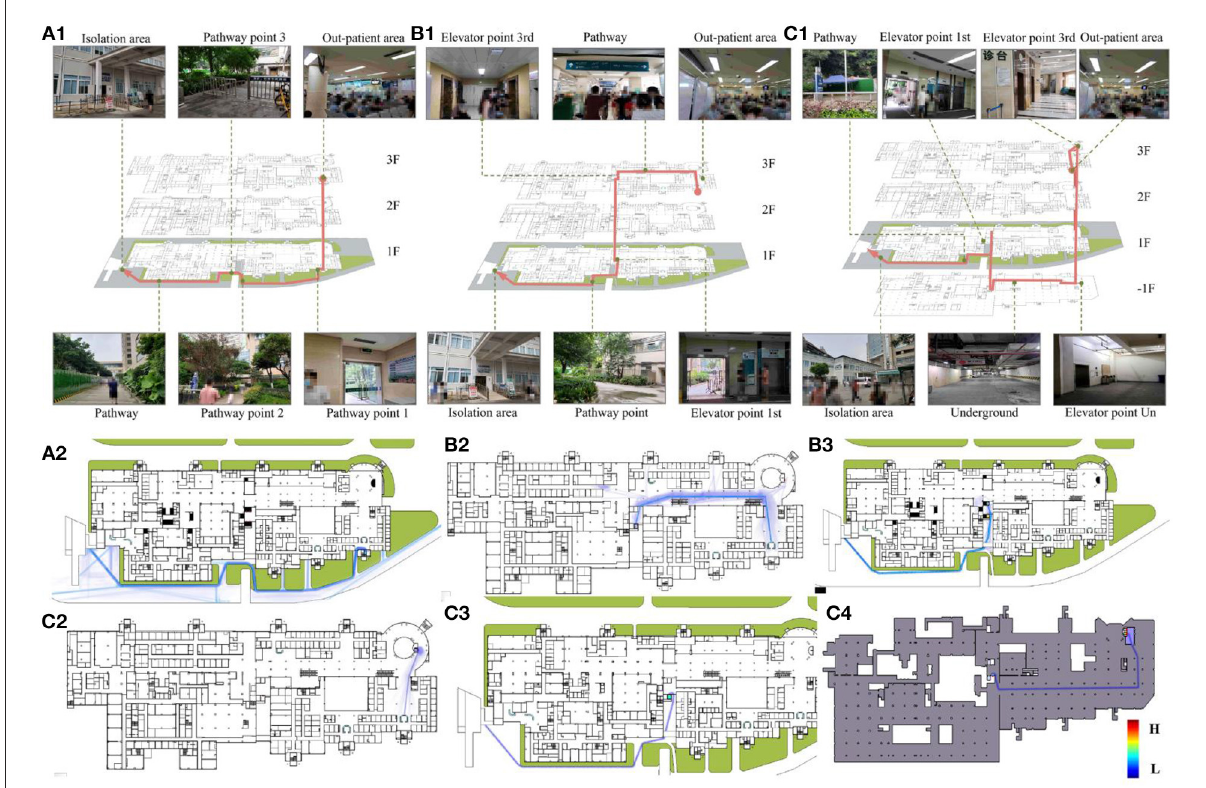
FIGURE3 Three candidate pathways were designed, and transportation time and flow rate were simulated per pathway. Path no. 1 was accessible by stairs and an outdoor walkway (A1) ; the time required to move from SP to EN was 190–263s and the number of potential contacts was in the range 85–115 (A2) . Path no. 2 was accessible from an indoor walkway, elevator, and outdoor walkway (B1) ; the time required to move from SP to EN was 220–296s and the number of potential contacts was in the range 150–200 (B2,B3) . Path no. 3 was accessible by elevator E1, basement, elevator E2, and an outdoor walkway (C1) ; the time required to move from SP to EN was 285–390s and the number of potential contacts was in the range 80–110 (C2–C4)